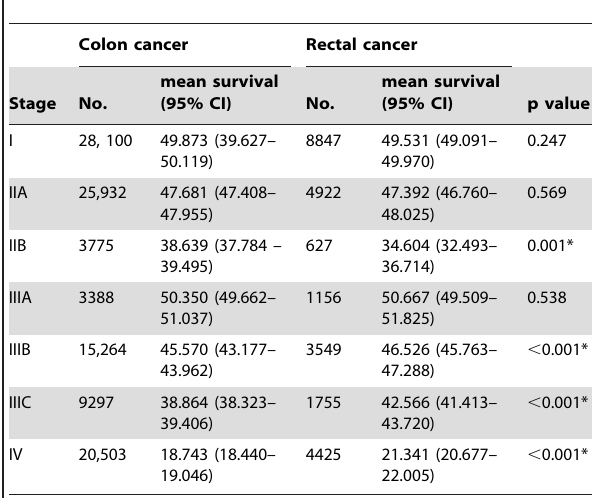
Table 4. Survival of patients (year) with different stages of colon or rectal cancer by